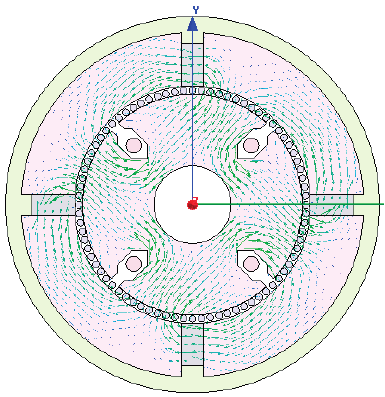
Figure 10. The cup rotor regarded as a squirrel-cage rotor.